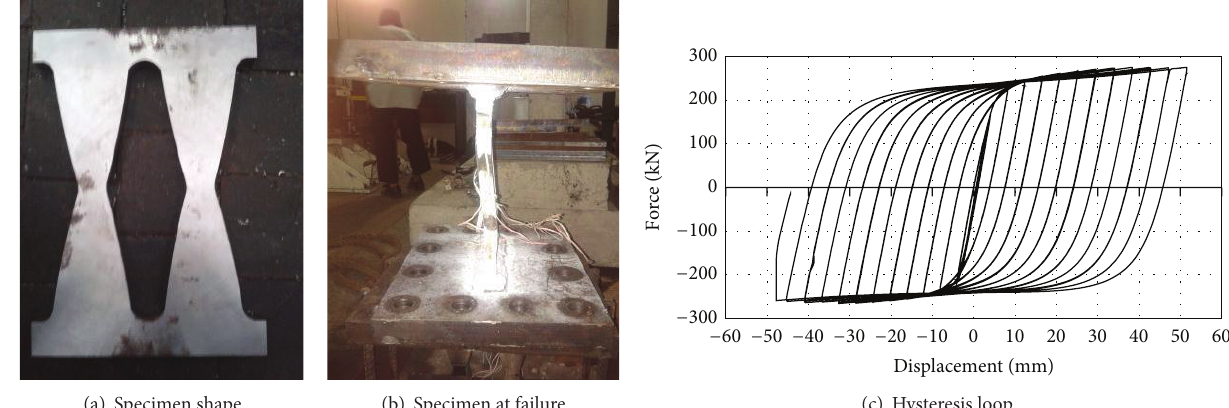
Figure 11: Results of specimen cyclic test for